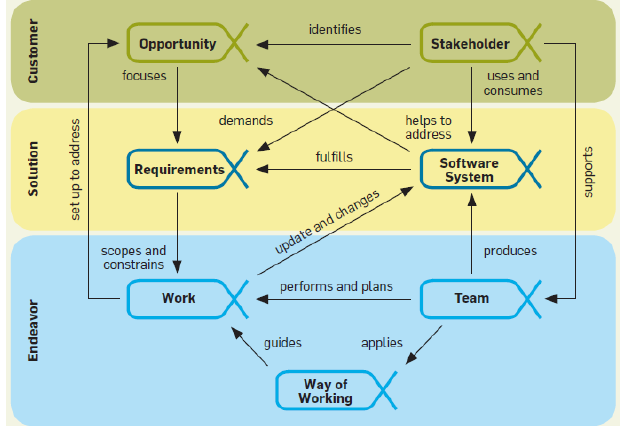
Fig. 1. Alphas for software essence kernel